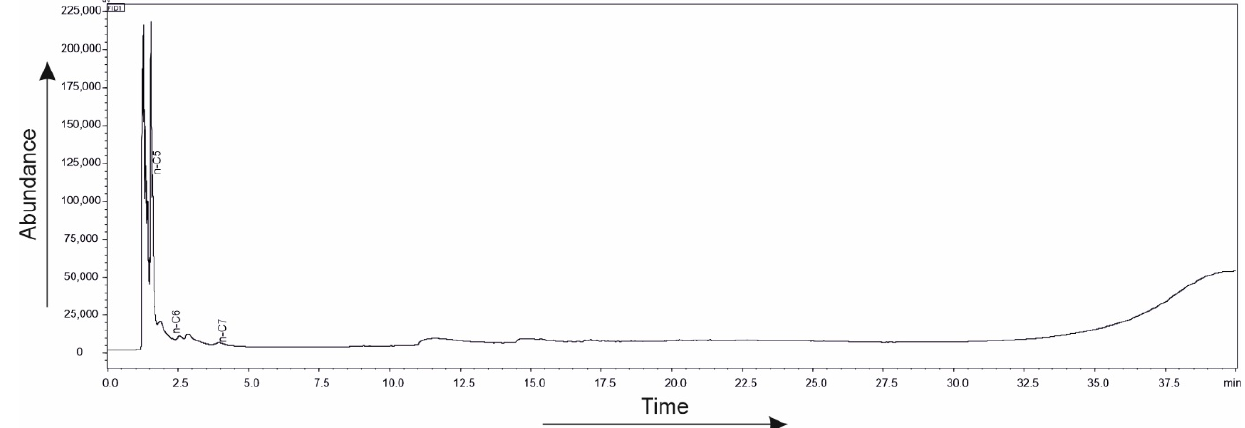
Figure 16. Distribution of hydrocarbon fractions generated through Py/GC at 300–650 °C, using the example of Sample 9